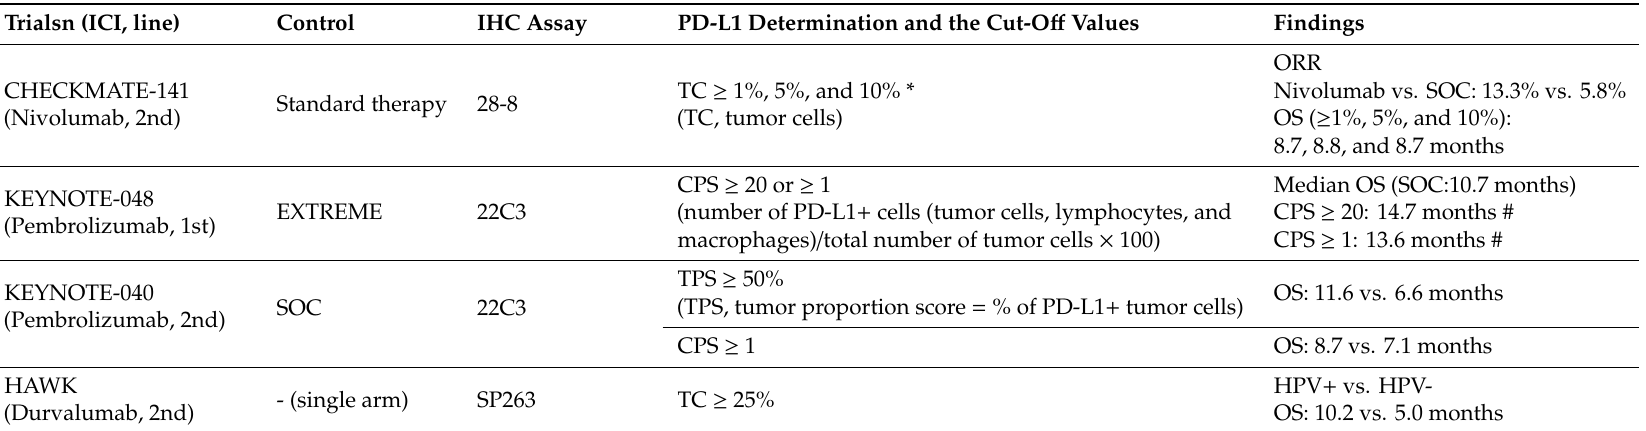
Table 1. Evidence for programmed death ligand-1 (PD-L1) expression cut-o ff values and corresponding immunotherapeutic agents in clinical